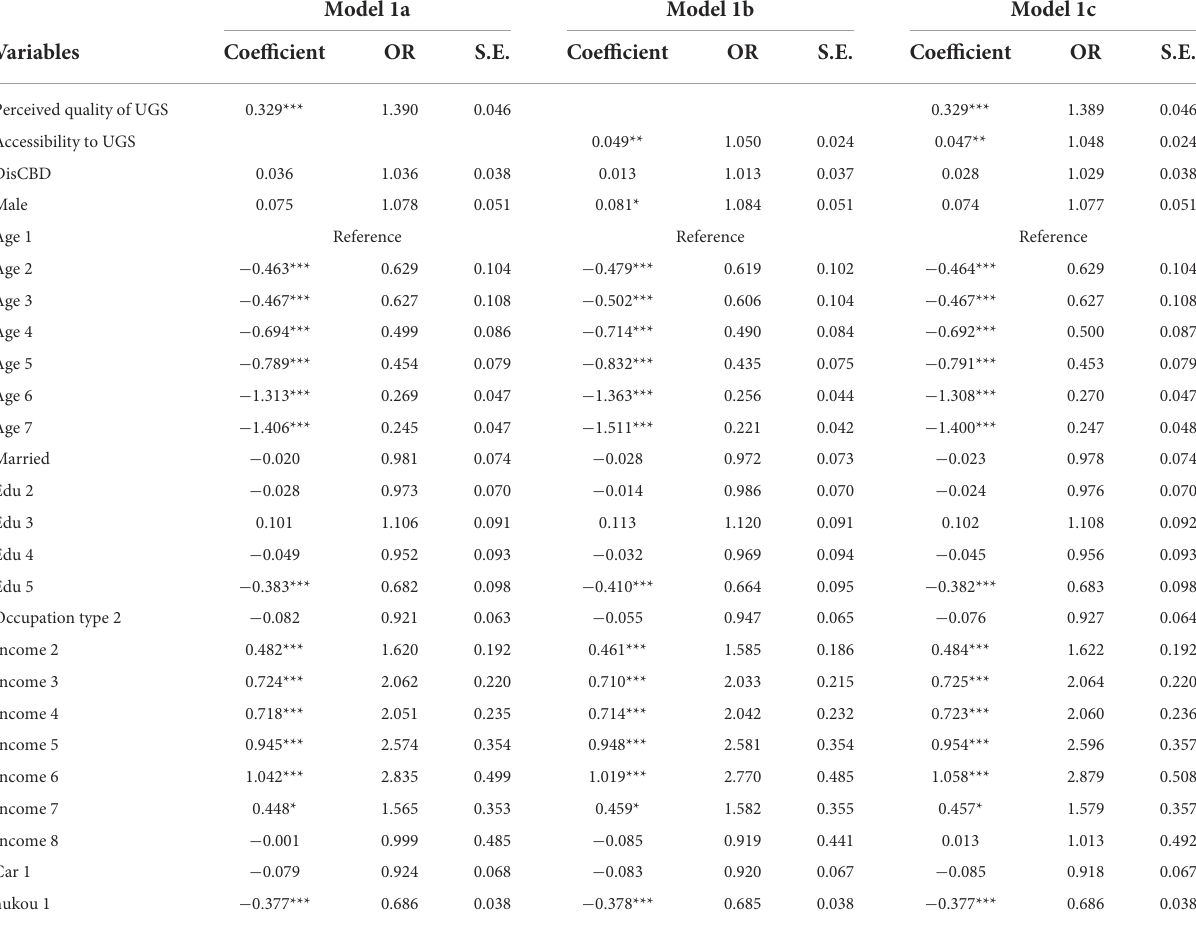
TABLE 4 Regression model results of the association between UGS and respondents’ SRH.